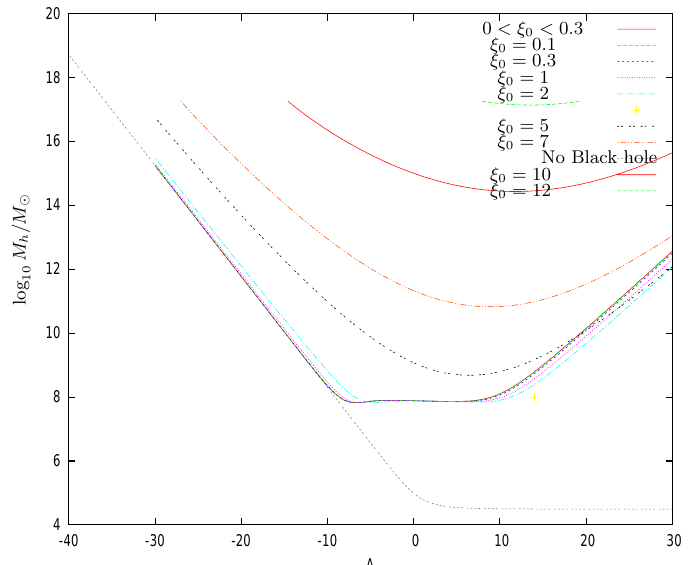
FIG. 6: The halo mass log 10 M h vs. the constant A of the chemical potential behaviour at the origen for fixed values of ξ 0 . The M h vs. the constant A of the chemical potential behavior at the origin Figure 6. The halo mass log 10 halo mass M h increases with ξ 0 at fixed A . M h increases when the absolute value of A increases at fixed ξ 0 > 0. In absence of for fixed values of ξ 0 . The halo mass M h increases with ξ 0 at fixed A . M h increases when the the central black hole, the halo mass monotonically decreases when A increases till M h reaches its minimal value eq.(4.1) at the degenerate quantum limit at zero temperature [9, 10, 12]. In the presence of a central black hole, we find a larger minimal absolute value of A increases at fixed ξ 0 > 0. In the absence of the central black hole, the halo mass value for the halo mass M min h monotonically decreases when A increases until M h reaches its minimal value , Equation (82) at the degenerate quantum limit at zero temperature [9,10,12]. In the presence of a central black hole, we find a larger minimal value for the halo mass M min Equation (83) with a non zero minimal temperature T min 0 h Equation (84) . Therefore, there is an important qualitative difference between galaxy solutions with a black hole ξ 0 > 0, and galaxy solutions without a black hole ξ 0 =